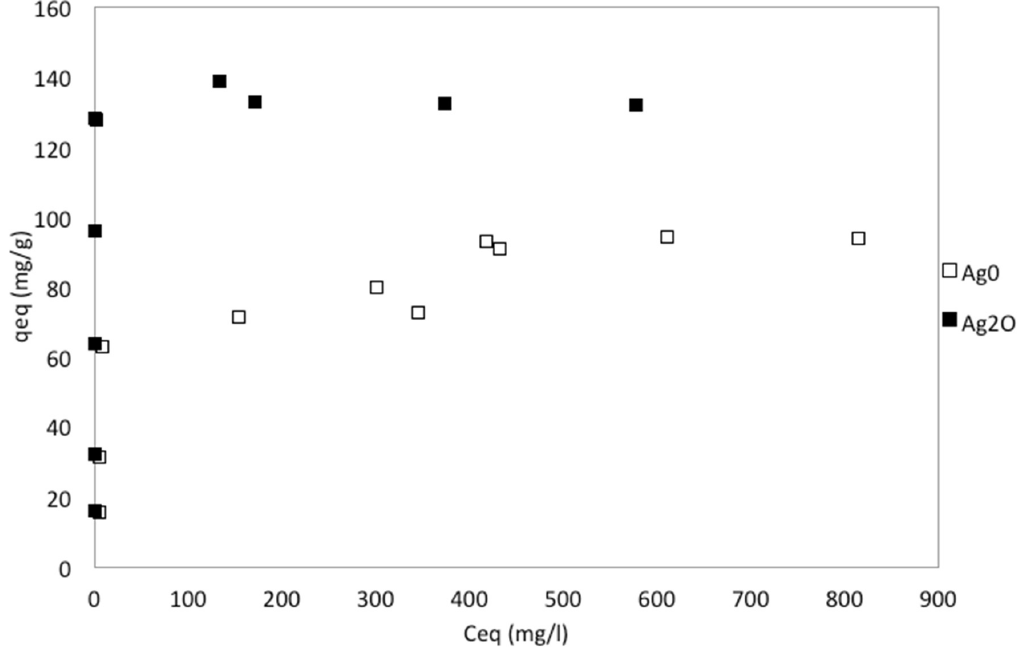
Figure 5. The adsorption equilibrium of iodide on zeolite nanocomposites.